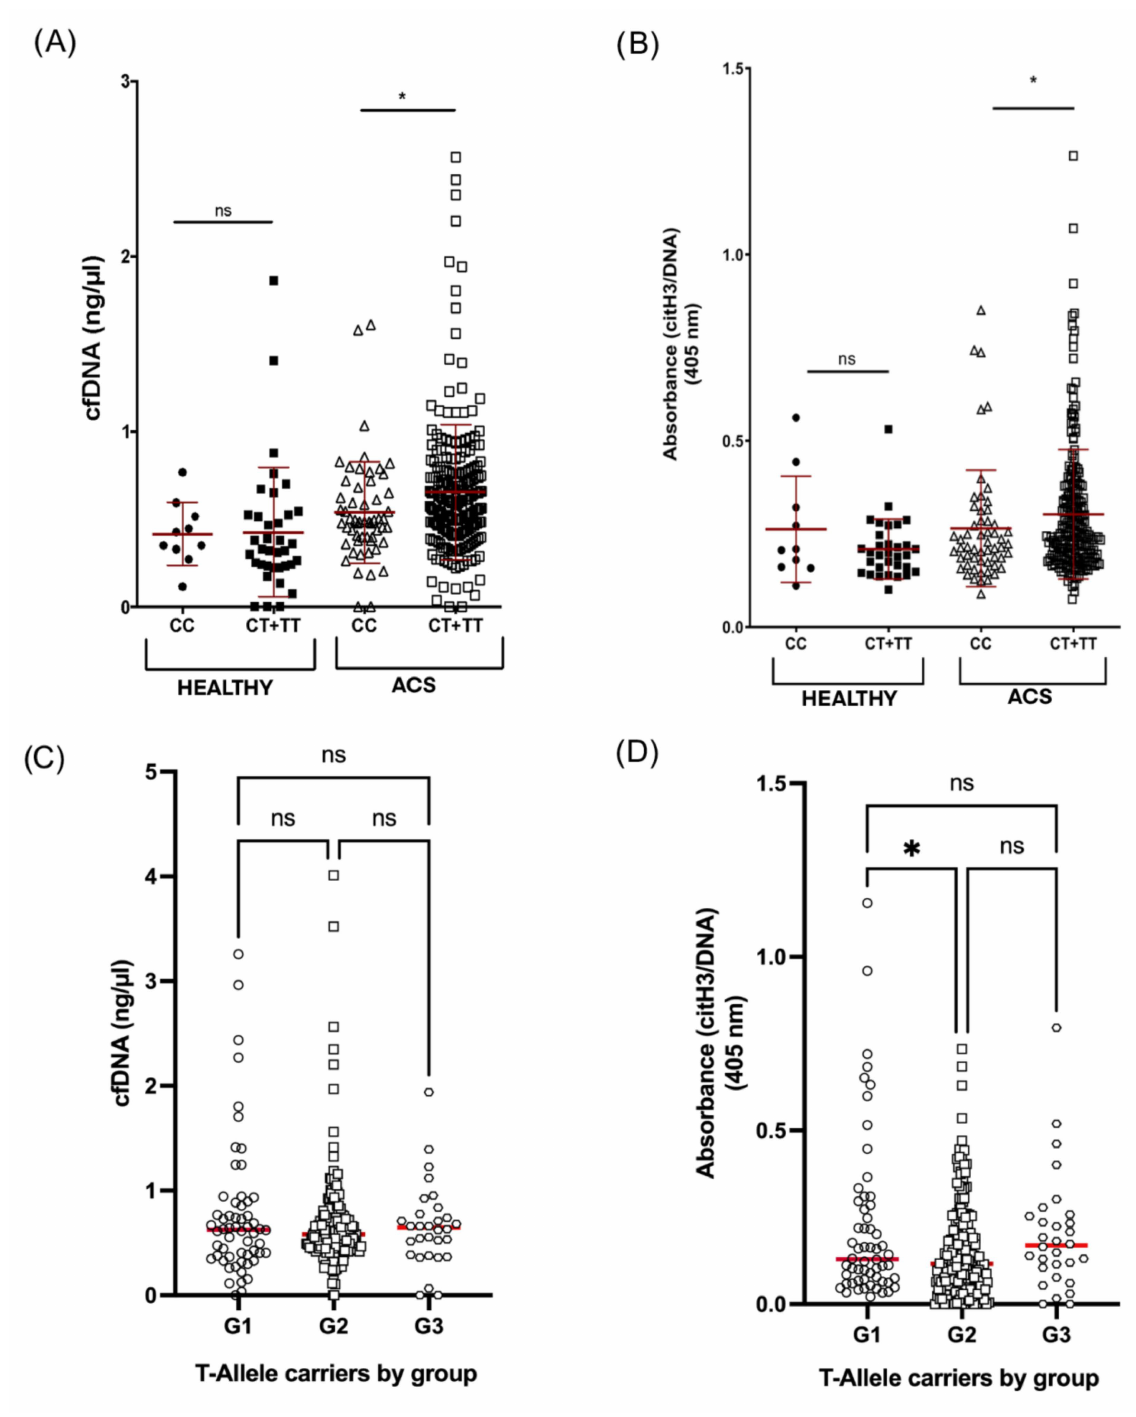
Figure 2. Levels of NETosis markers in young ACS patients by genotype. ( A , B ) cfDNA levels and citH3–DNA complexes levels in healthy donors or ACS patients considering the dominant model of rs2431697 genotype, CC (n = 56) vs. CT and TT (n = 231). ( C , D ) cfDNA levels and citH3–DNA complexes levels in those patients carrying the T-allele of rs2431697 in G1 (n = 58), G2 (n = 196) and G3 (n = 30). ns: not significant; * p <